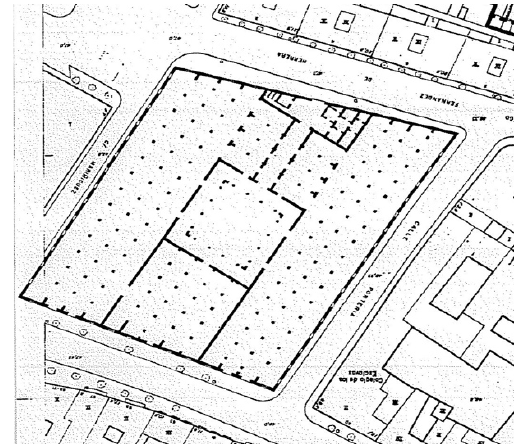
Figure 8. Cloister plant example. Bodega El Cuadra, 1810-1819. (Delegación Municipal Urbanismo, Jerez de la Frontera,